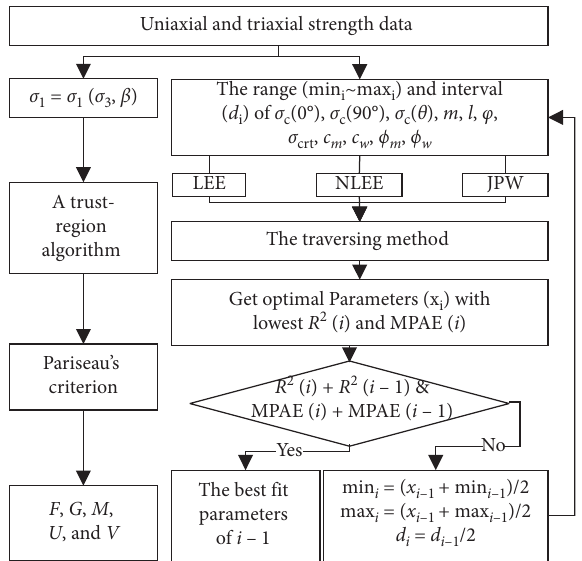
Figure 5: Flow Chart of algorithm of fit. Table 3: The material coefficients of different